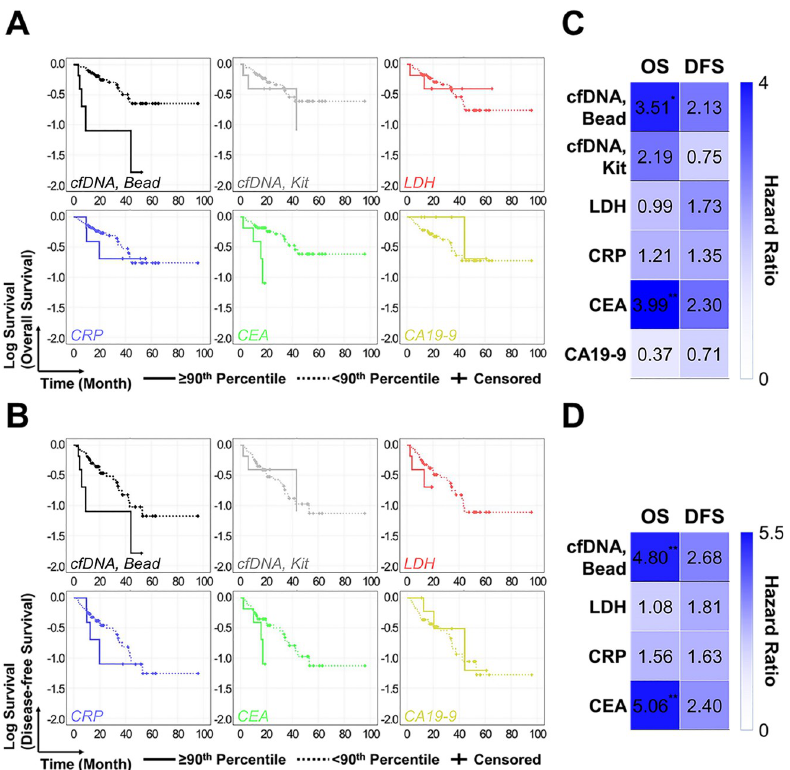
Fig 4. Kaplan Meier survival analysis and Cox regression analysis for demonstrating the prognostic and predictive value of the new cfDNA separation platform for patients with gastric cancer. (a, b) Kaplan Meier survival analysis of different blood tests. 90 th percentile was set as a cutoff for each test. (c, d) Cox regression analysis of different blood test. 90 th percentile was set as a cutoff for each